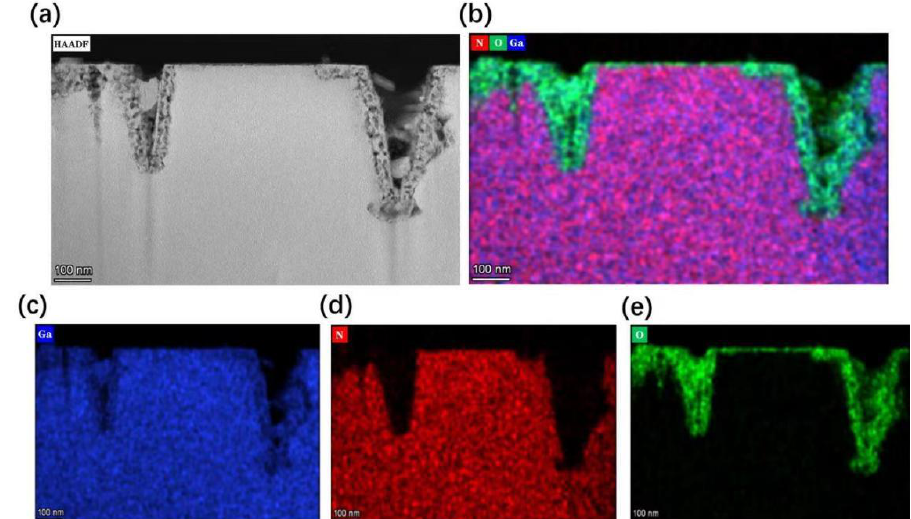
Figure 7. ( a ) Cross-section SEM image of Ga 2 O 3 /GaN NRA and ( b ) corresponding element mapping; ( c ), ( d ), and ( e ) are distribution diagrams of Ga, N and O elements respectively.